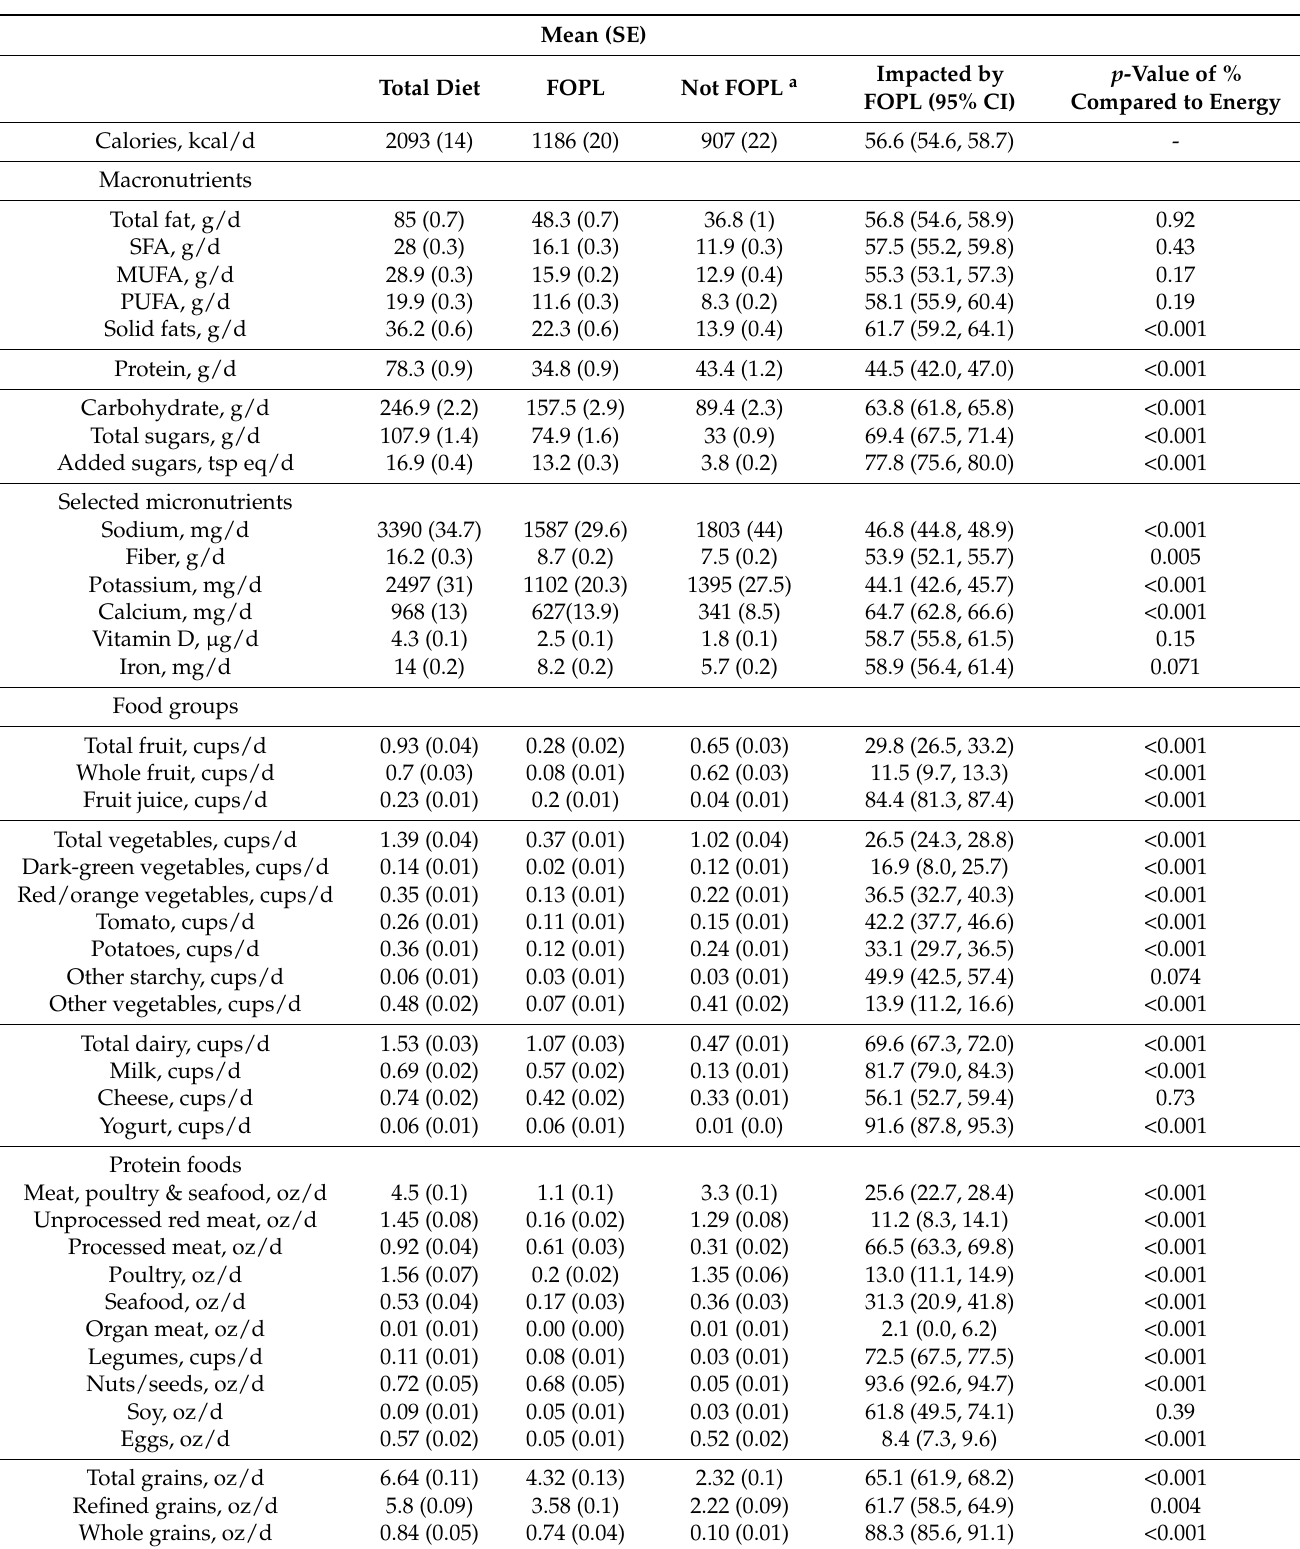
Table 4. Proportion of population’s dietary constituents impacted by FOPL in the US,